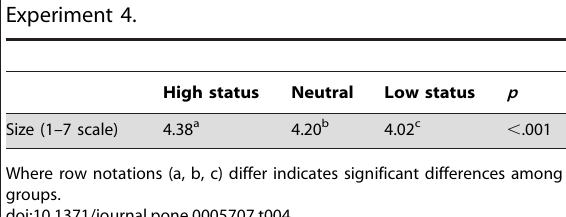
Experiment 4: Effects of specific cues on perceptions of size and dominance